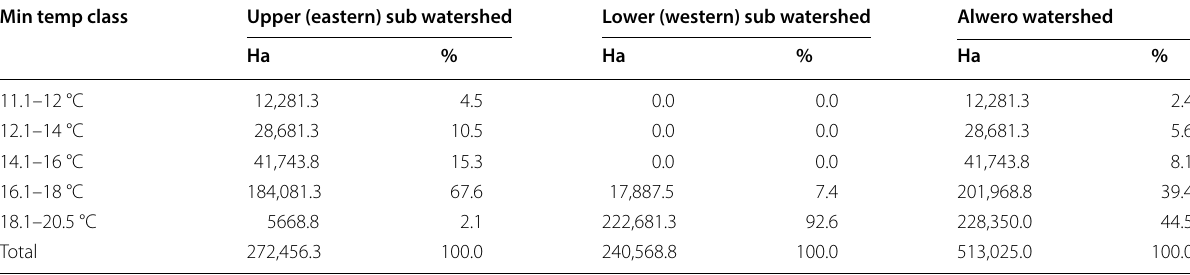
Table 4 Minimum temperature distribution in Alwero watershed Min temp class Upper (eastern) sub watershed